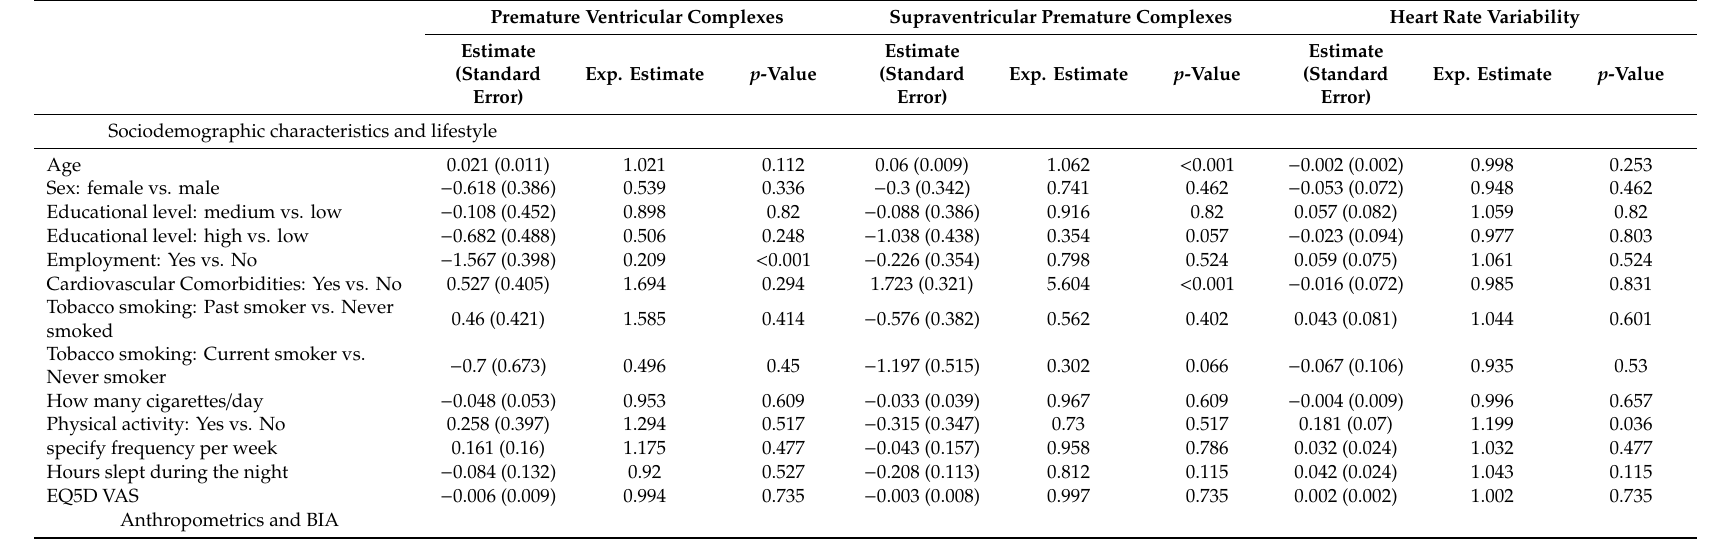
Table 3. Results of univariable analyses for premature ventricular complexes, supraventricular premature complexes, and heart rate variability. Exp estimate represents E[(Y + 1); X] / E [Y; X] indicating the relative variation in the expected number of arrhythmic events consequently to a unit increase of each considered X